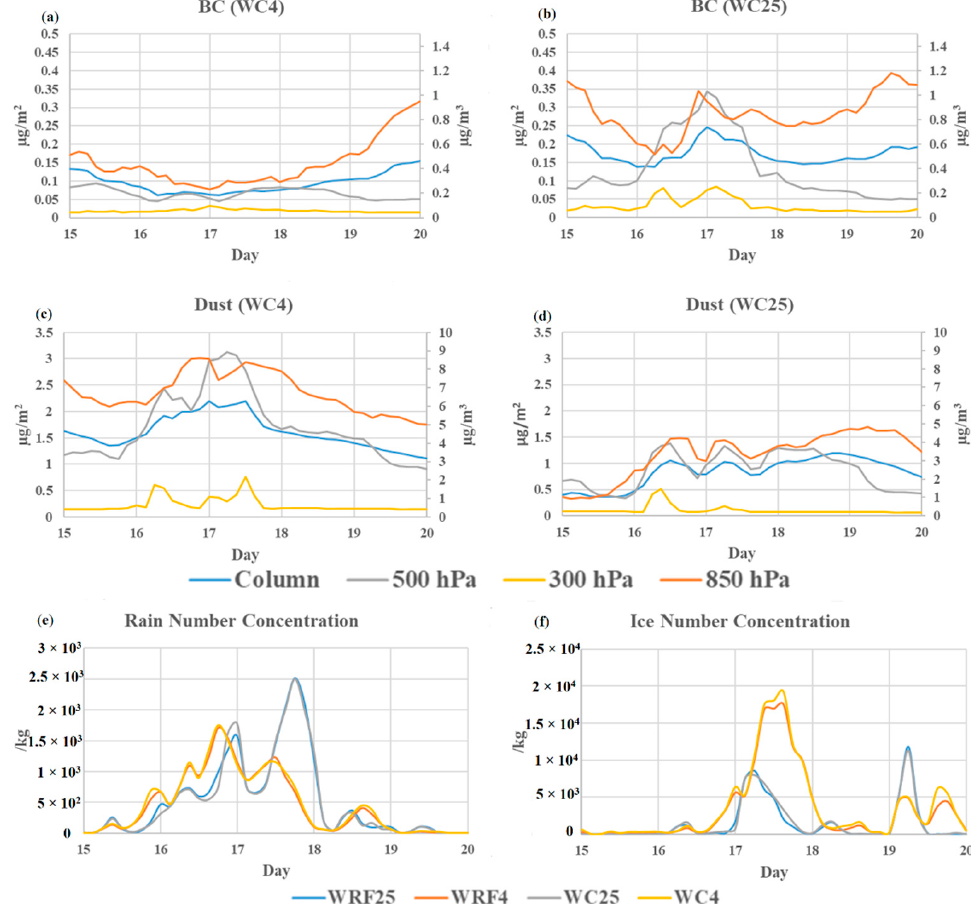
Figure 6. ( a , b ) BC concentration from 15–19 June 2013 at 850 hPa, 500 hPa, 300 hPa, and the columnar average at the 4 km and 25 km resolutions ( c , d ) for dust. ( e ) Rain number and ( f ) ice number concentration with different model simulations.